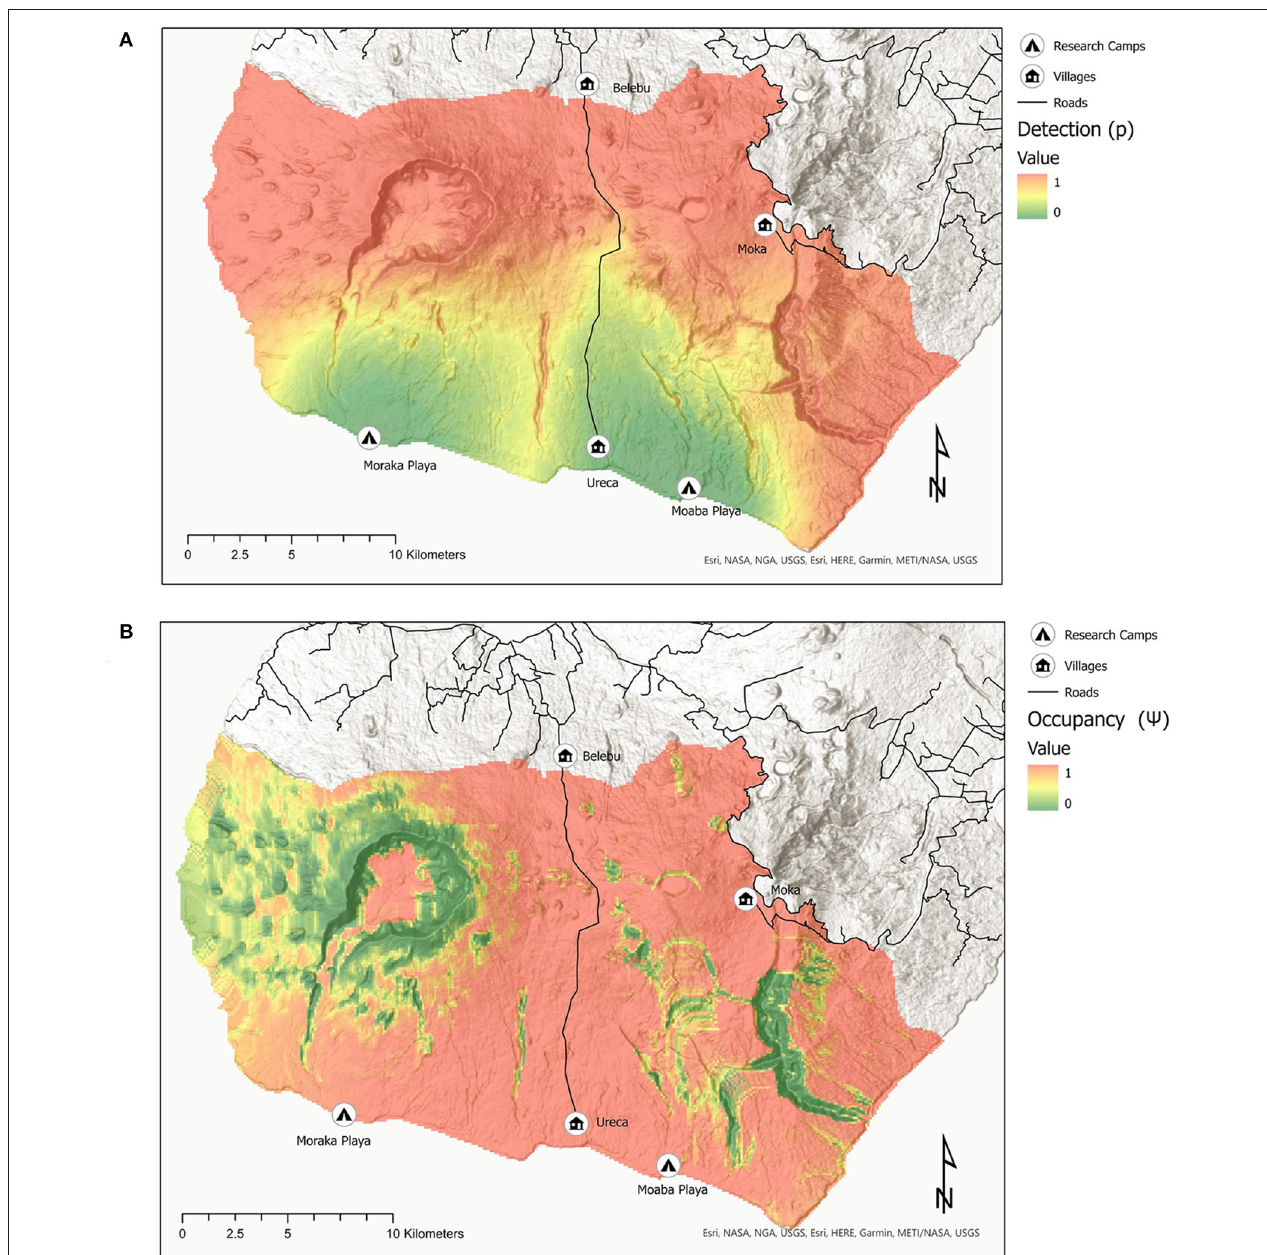
FIGURE 5 | Maps showing the best fitted occupancy model [ 9 (Hetro + Roads + Village + Camps); p(Hetro + Moon + Camps + Road + Village] predicting detectability (A) and occupancy (B) of hunting across the Gran Caldera de Luba Scientific Reserve.